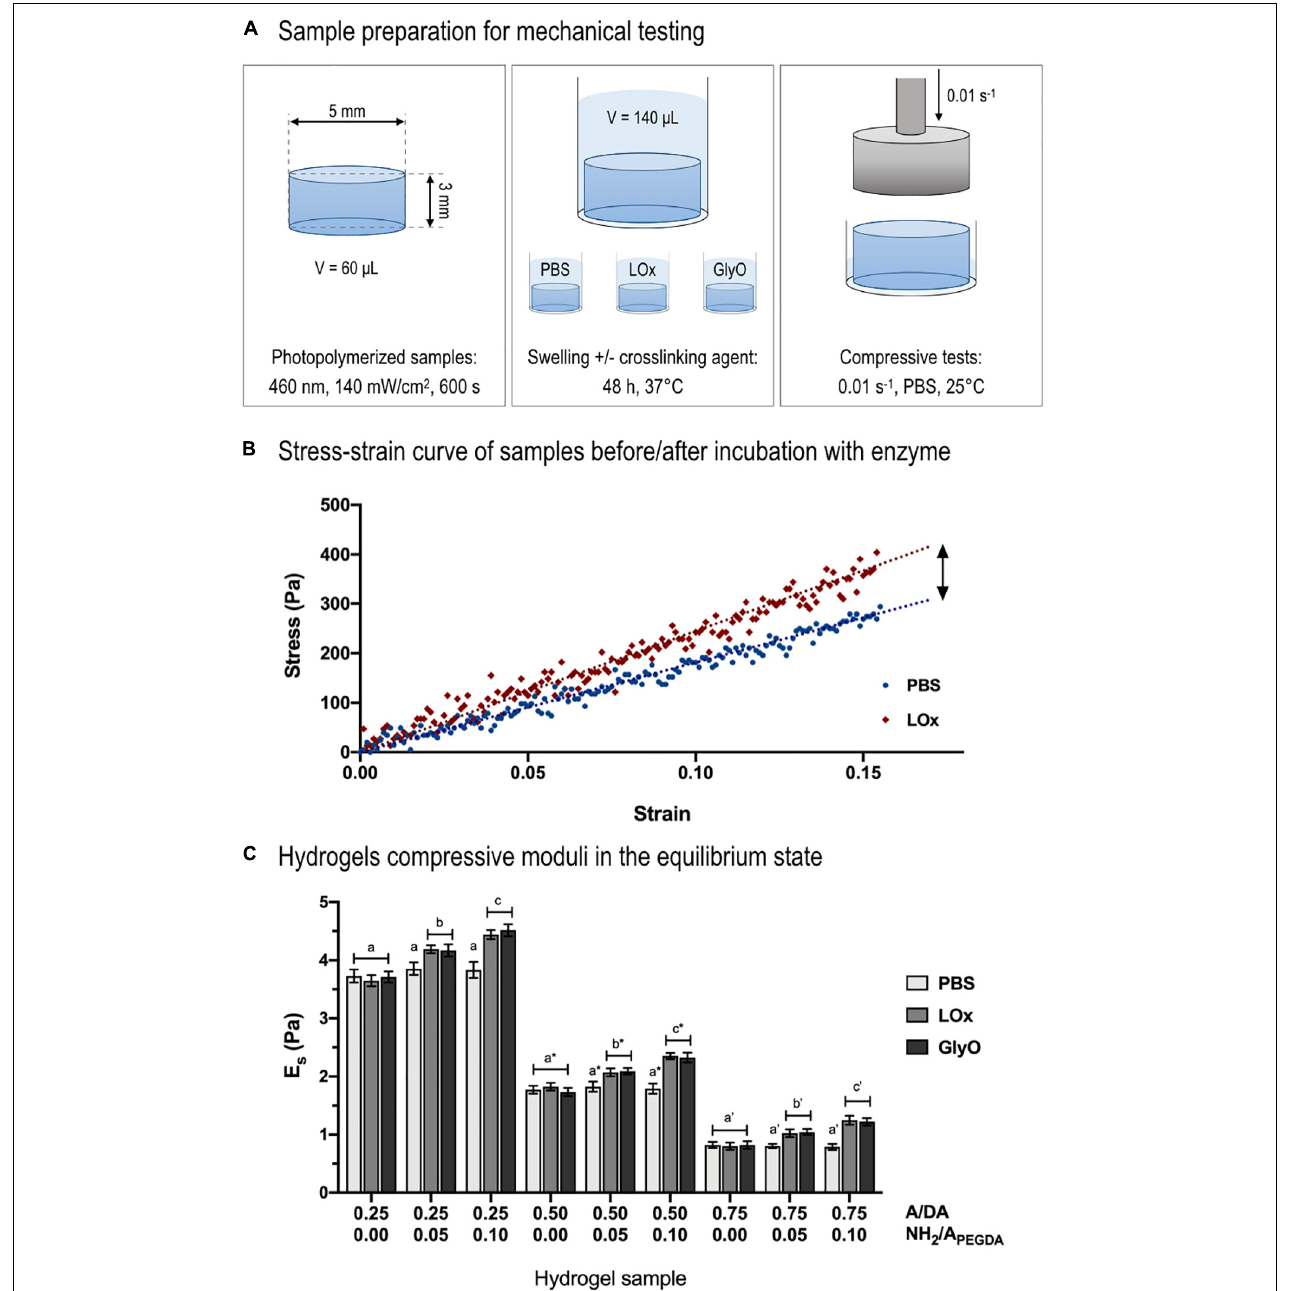
FIGURE 5 | Compressive mechanical tests. (A) Schematic representing sample preparation for mechanical testing. (B) Example of stress–strain curve of 0.50 to 0.10 A/DA-NH 2 /A PEGDA hydrogel before (blue dots) and after incubation with LOx (red diamonds). Typical linear fitting curve data within 15% strain (blue and red dotted lines) are displayed to show the linear (elastic) behavior of hydrogels during compression. (C) Hydrogel compressive moduli ( E s ) measured after incubation with LOx, GlyO (positive control) or PBS (negative control). One-way ANOVA was performed considering each A/DA hydrogel family independently, with differences p < 0.05 considered statistically different. Letters with no sign indicate ANOVA results obtained analyzing the 0.25 A/DA hydrogel family, whereas letters with an asterisk and those with an apostrophe are referred to ANOVA results obtained for the 0.50 and the 0.75 A/DA families, respectively. Different letters indicate significant differences between samples ( p < 0.05).